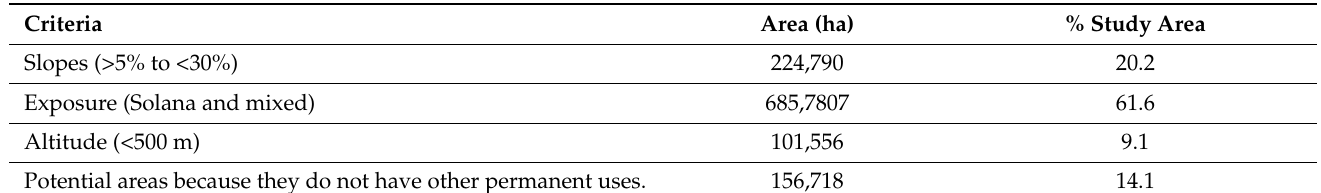
Table 5. Description of criteria for the integrated analysis and their extension in the study area.